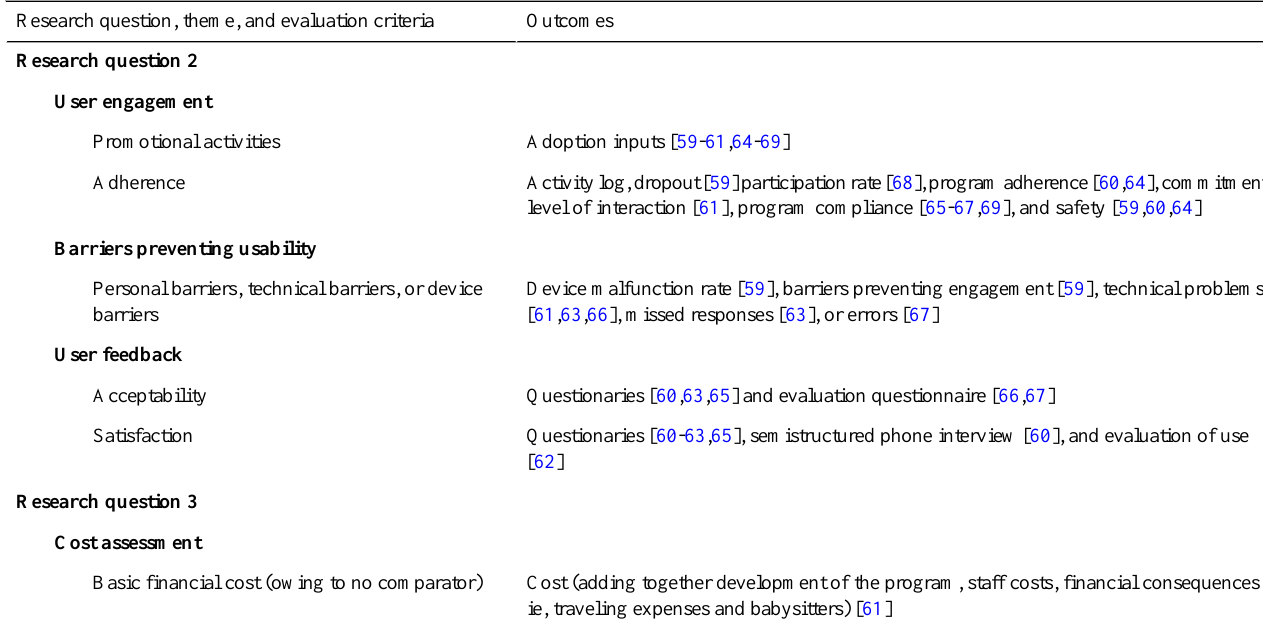
Table 2. Formation of themes, evaluation criteria, and main outcomes supporting the delivery of the eHealth and mobile health interventions for juvenile idiopathic arthritis.